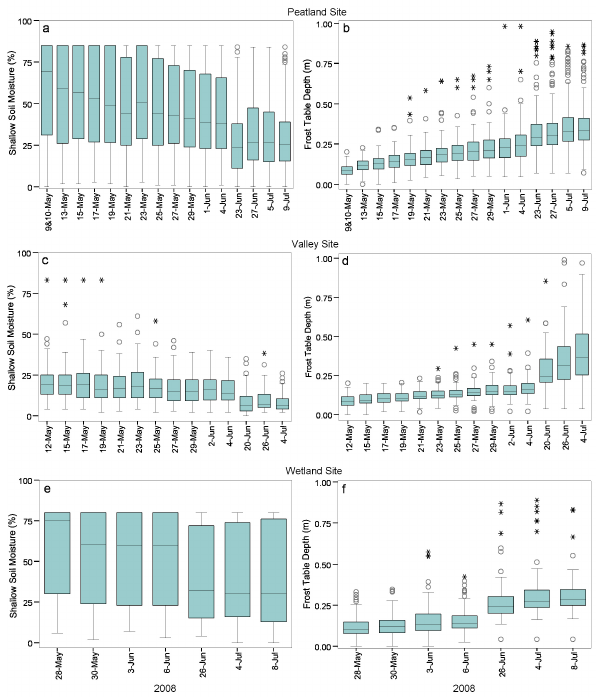
Fig. 2. Boxplots showing range in shallow soil moisture and frost table depth over time. Circles indicate outliers and asterisks indi- cate extreme outliers. These outliers are natural variabilities in the dataset. Excluded are frost table sample points with ≥ 1m depth.